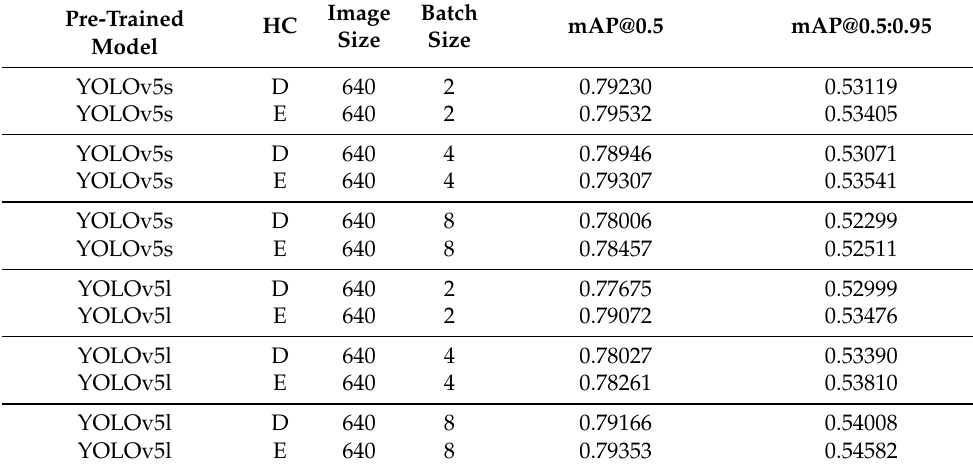
Table 2. Evaluation results for mAP@0.5 and mAP@0.5:0.95 for different hyperparameter configura- tions (HC), for default values (D) and optimised values with evolution